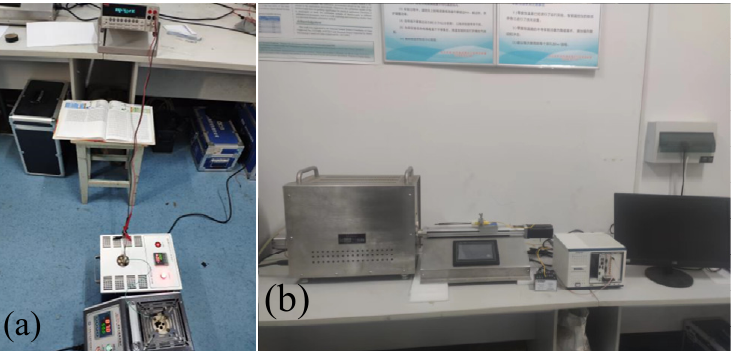
Figure 9. Static test system: ( a ) Low temperature section static test site; ( b ) Horizontal high tempera- ture verification furnace static test system.